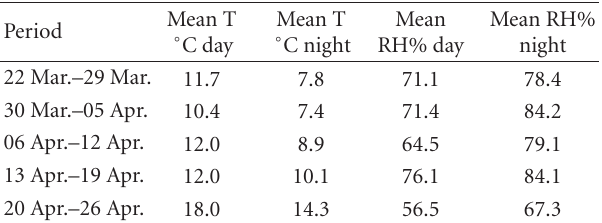
Table 2: Temperatures and RH% during the course of the experiment, from Mar 22nd to Apr. 28th 2002. Increase of Azolla biomass is somewhat dependent on air humidity as at less than 60% of relative humidity, the fern becomes dehydrated and fragile. During the experiment, the RH% dipped below this critical level for a brief